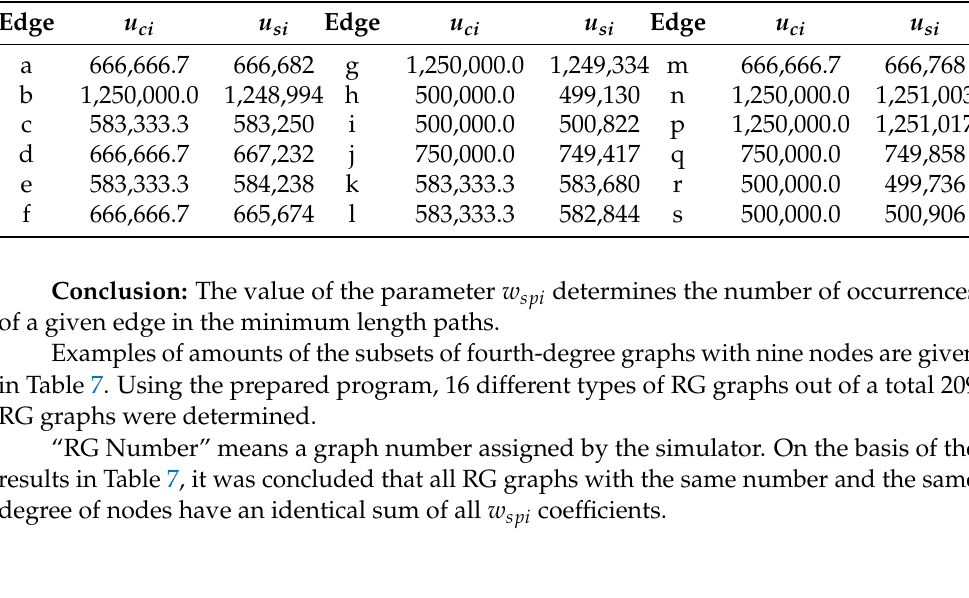
Table 6. Comparison of results obtained via calculations and